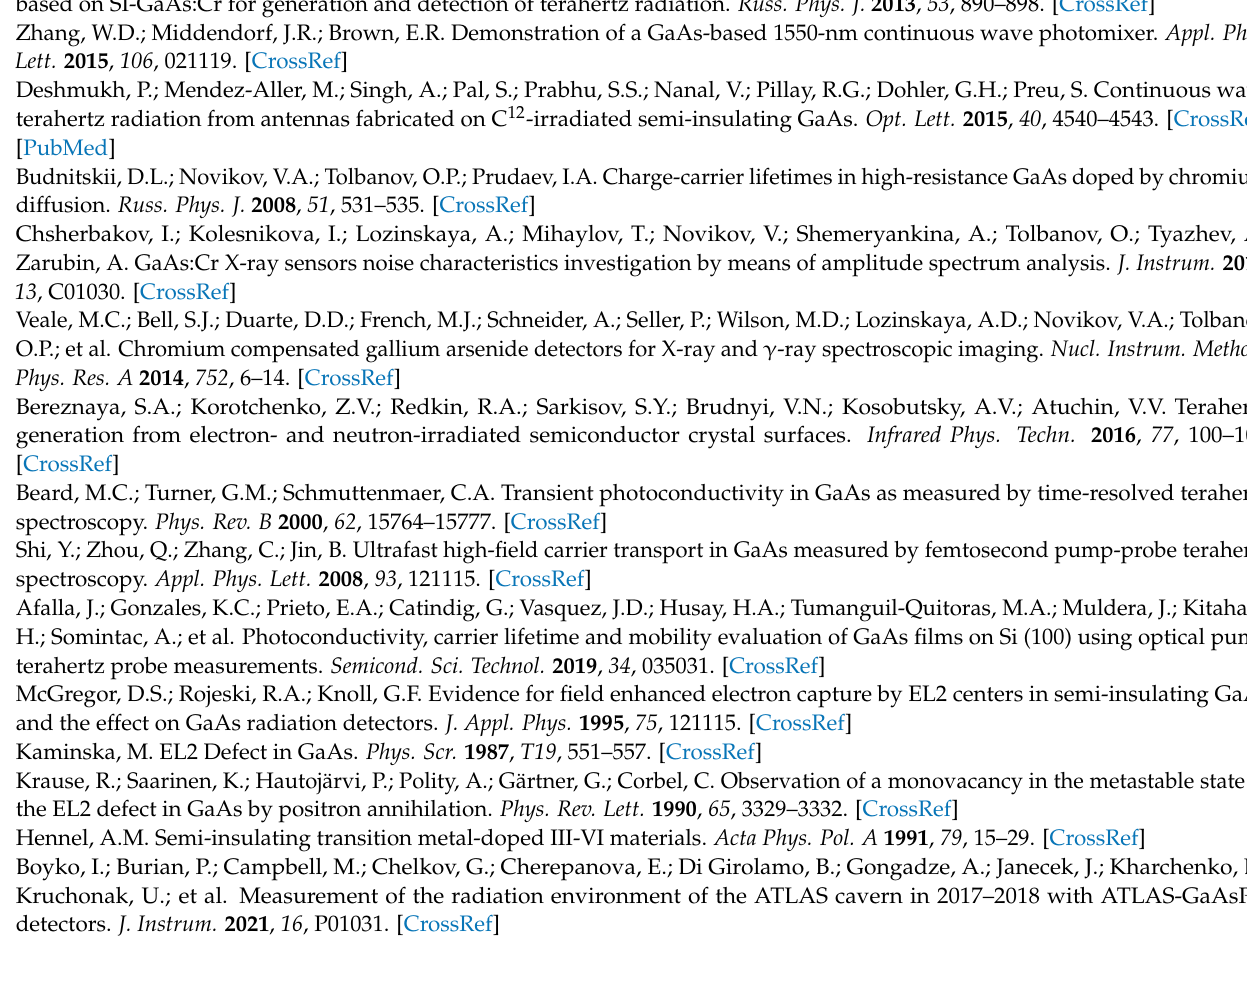
mechanisms. Figure S6. The AFM data for HR GaAs:Cr wafers: ( a ) initial, ( b ) after etching in sulfuric acid solution and ( c ) after grinding the surface. The analysis justifying the Equation